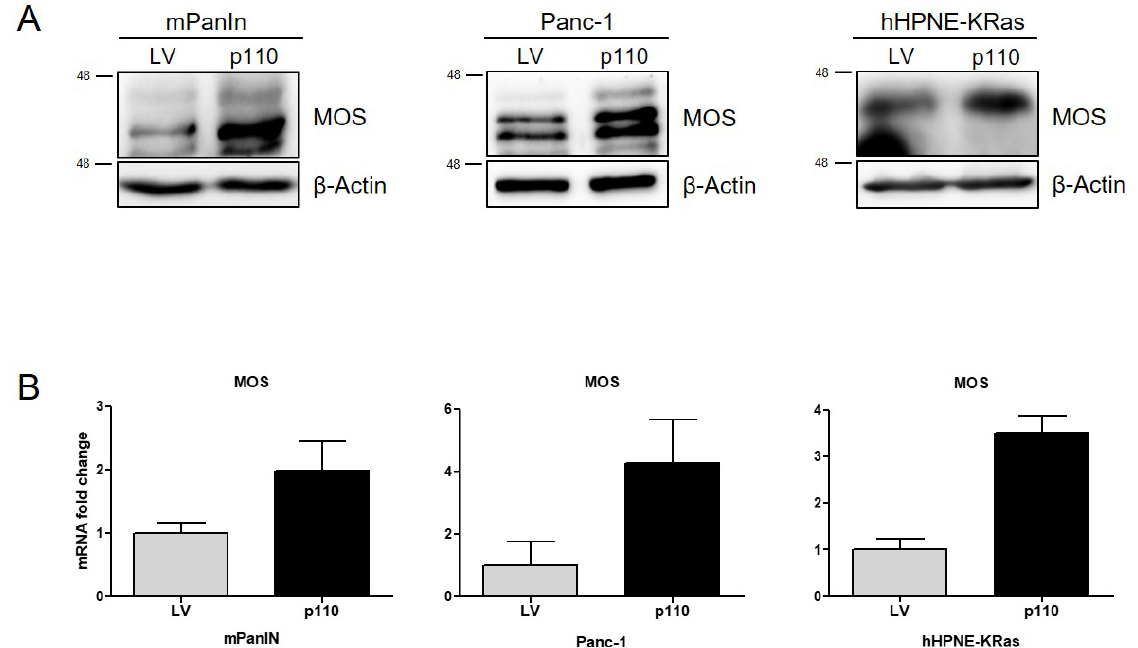
Figure 7. p110 CUX1 increases MOS in KRAS-mutant pancreatic cell lines. ( A ) Western blot analysis of whole protein cell lysates from stable transduced mPanIn, Panc-1 and hHPNE-KRAS cells. Compared to empty vector (LV) control cells, overexpression of p110 CUX1 increased protein levels of MOS in all three pancreatic cell lines. Actin served as control. ( B ) Representative quantitative RT-PCR analysis of MOS mRNA in empty vector (LV) and p110 CUX1 overexpressing mPanIN, Panc-1 and hHPNE-KRAS cells. MOS expression was normalized to the ribosomal protein RPLP0 as internal standard. The uncropped Western Blot images can be found in Figure S9 and the densitometry analysis can be found in Figure S10.